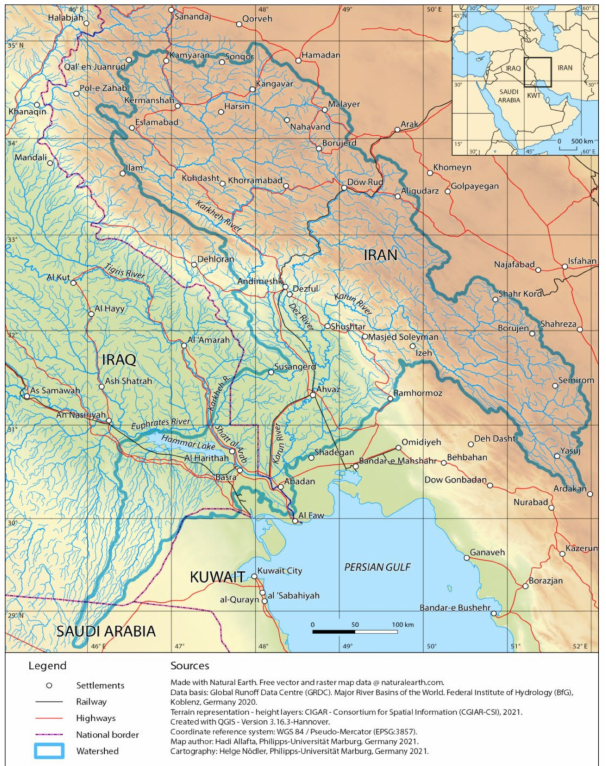
Figure 1. Study site. Note. From “GIS-based Multi-Criteria Analysis for Flood Prone Areas Mapping in the Trans-boundary Shatt Al-Arab Basin, Iraq–Iran”